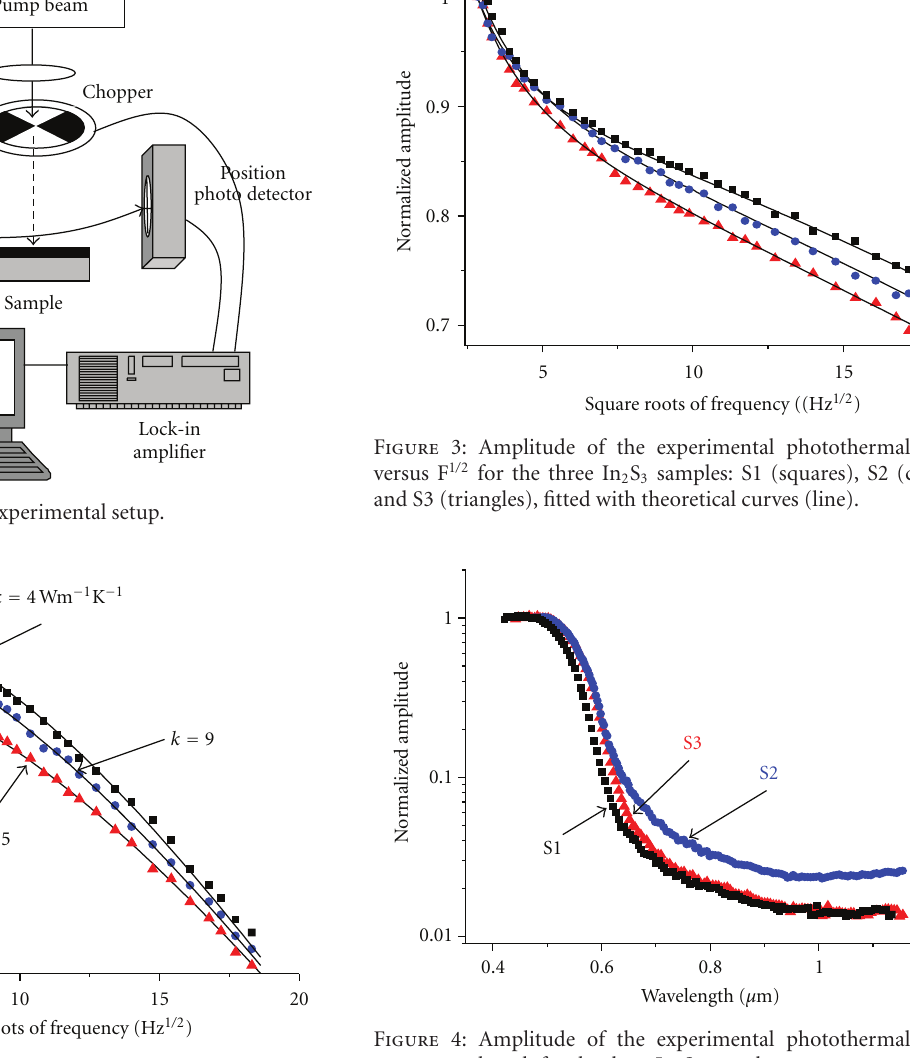
Figure 2: Phase of the experimental photothermal signal versus F 1 / 2 for the three In 2 S 3 samples: S1 (squares), S2 (circles), and S3 (triangles), fitted with theoretical curves (lines).